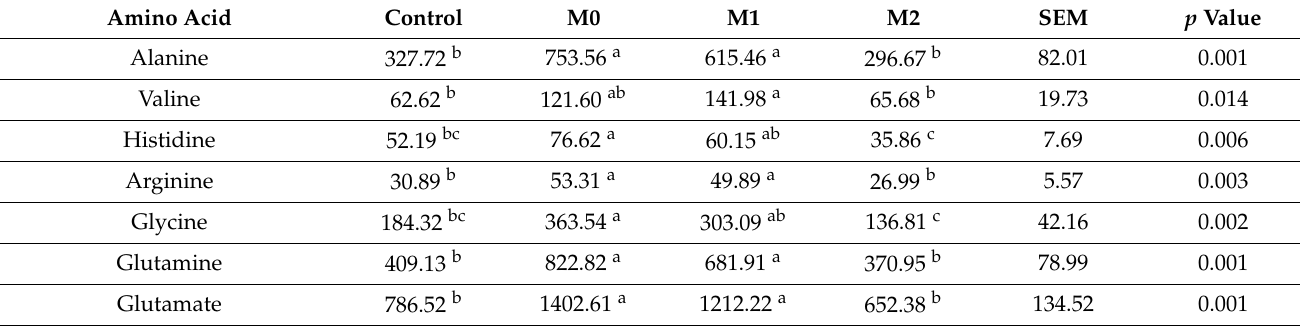
Table 5. Amino acid profile in different treatment groups